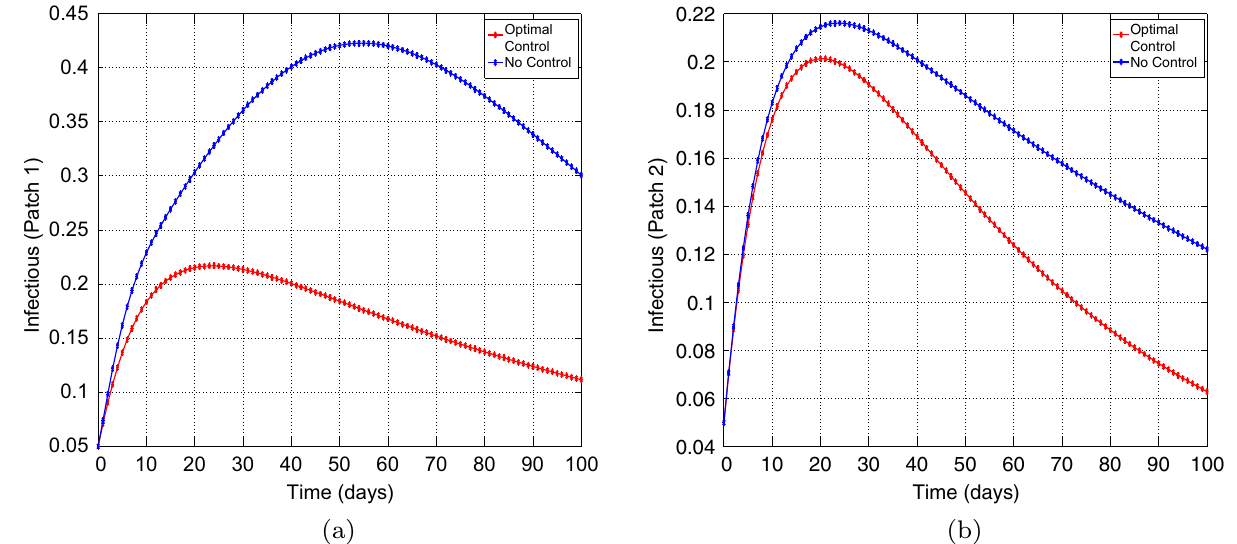
Figure 10. Simulation outcomes for the presented two patch COVID-19 mathematical model for case 2 under asymmetric strong coupling ( a ) the number of infected humans in patch 1 ( b ) the number of infected humans in patch 2. In both figures, the red curves and blue curves are for the infected population, with optimal control and no optimal control